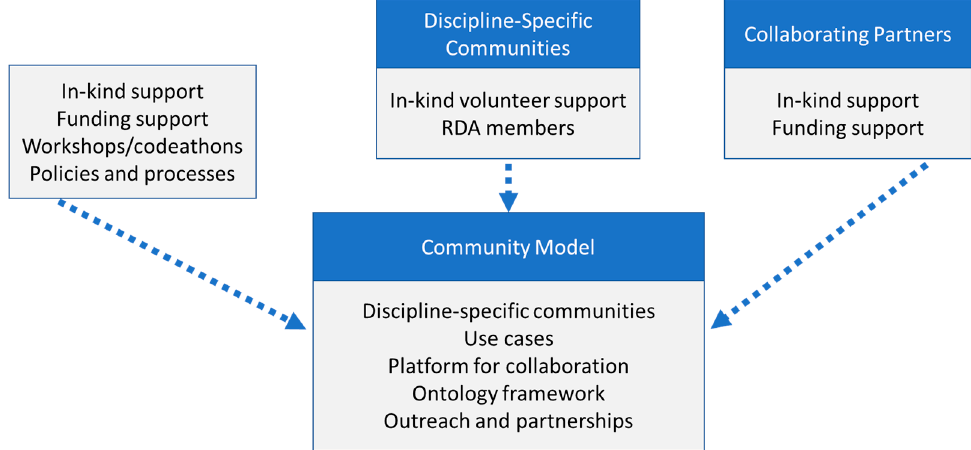
Figure 4. Sustaining the community.